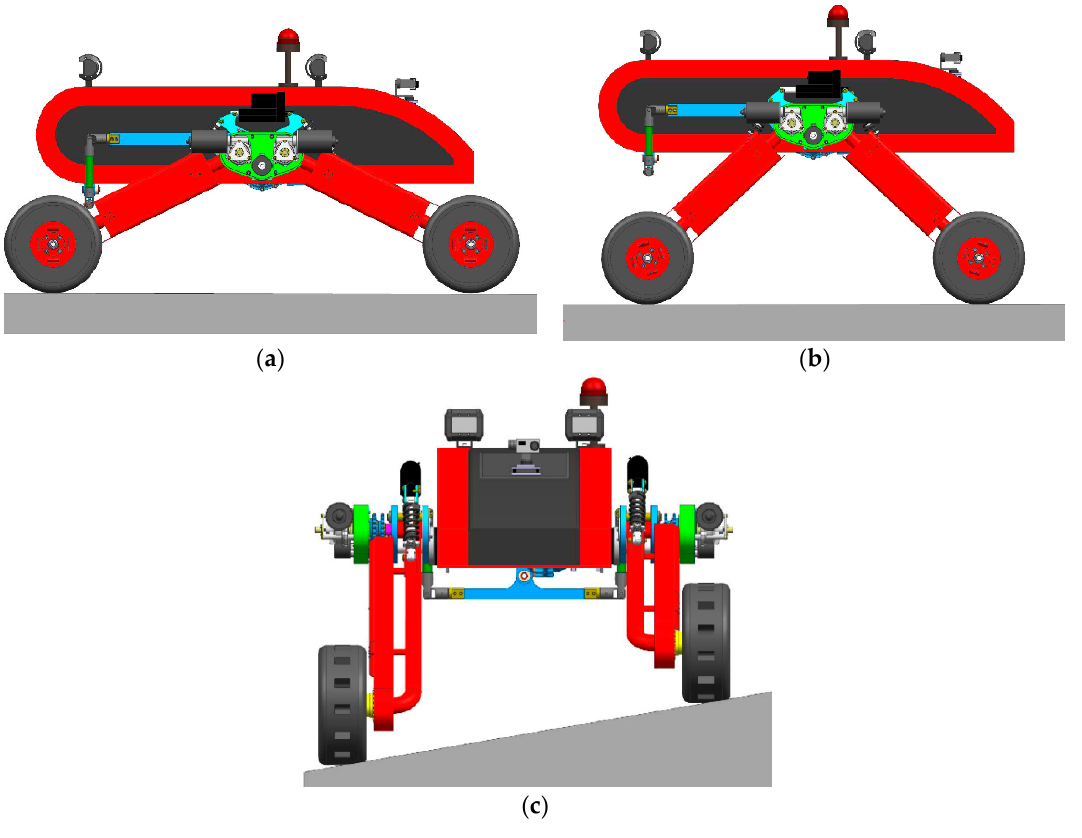
Figure 3. Mobile robot reconfigurations: ( a ) Low ground clearance; ( b ) High ground clearance; ( c ) Leveled configuration.